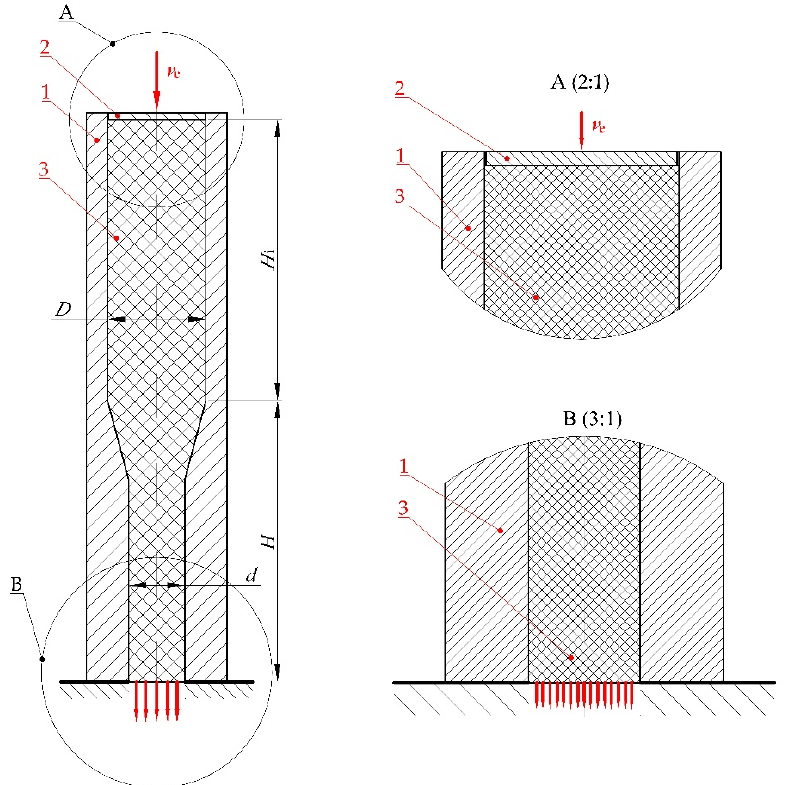
Figure 8. Schematic of the extrusion process during numerical analysis: 1—single-hole die integrated with feed barrel, 2—ram, 3—compressed dry ice snow, v e —extrusion speed, D —inlet diameter, d —outlet diameter, H —overall height of the die, H i —initial height of the extruded material.